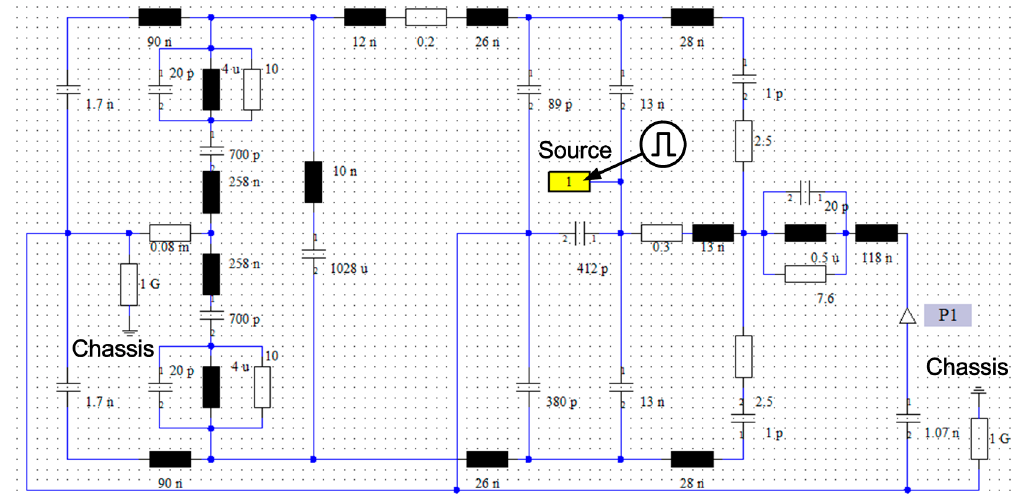
Figure 20. SPICE model in time ‐ domain simulation added CM ferrite chokes through the Y ‐ caps and the AC bus bar.